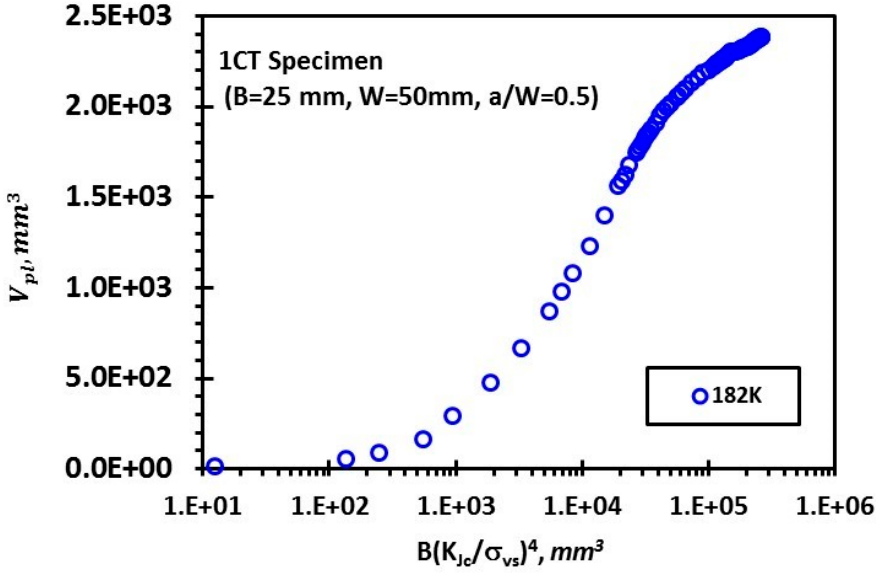
Figure 5. Variation of volume of plastic zone V pl with the compound parameter B ( K Jc / σ ys ) 4 .